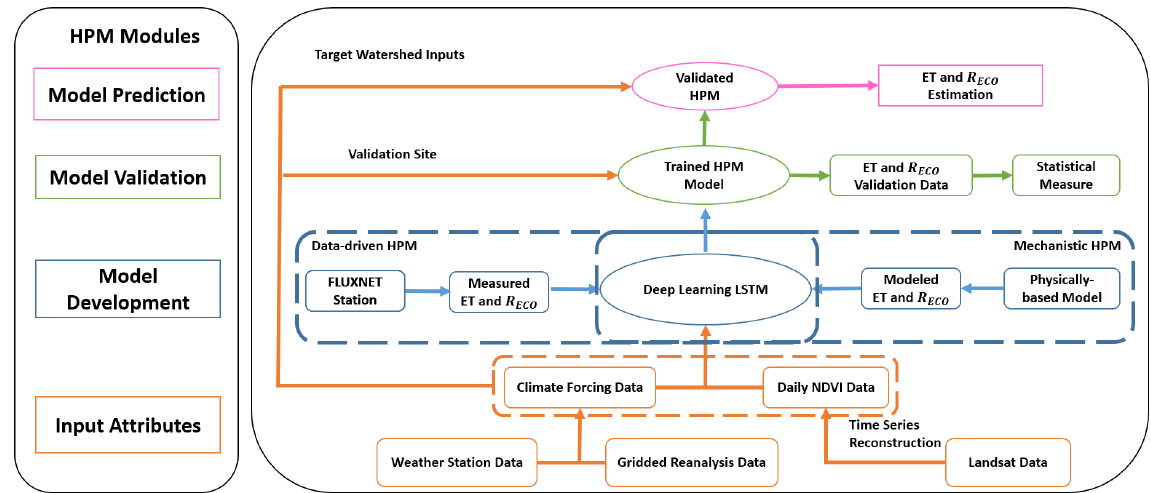
Figure 3. Hybrid predictive model (HPM) framework. The HPM model mainly consists of four modules: input attributes, model development, model validation, and model prediction, represented by rectangles with colors. Arrows represent the linkages among different modules. Choices of data-driven HPM or mechanistic HPM depend on the ecoregion of target watershed and data availability.